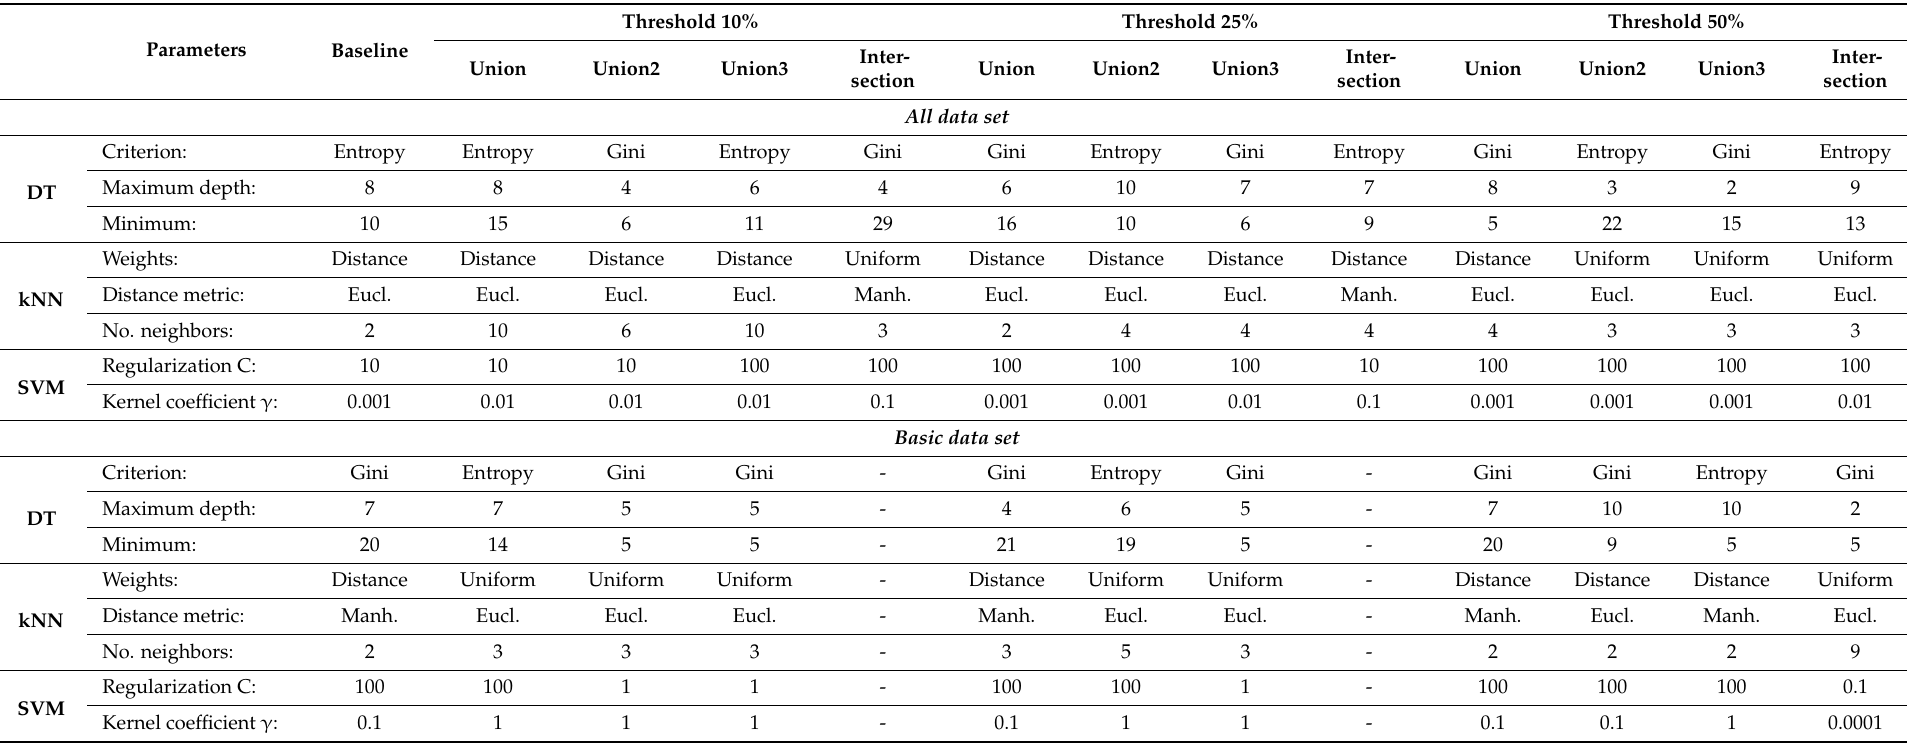
Table A1. Results of the hyperparameter optimization for each data set; Decision Tree (DT); k-Nearest Neighbor (kNN); Support Vector Machine (SVM); Euclidean (Eucl.); Manhattan (Manh.). Expanded Disability Status Scale (EDSS); Basic data set = 25 Foot Walk Test + 2-minute walk test + EDSS; All data set = All features of the Basic data set , the GAITRite System data sets, the Mobility Lab Gait data sets, the Twelve Item Multiple Sclerosis Walking Scale data set and the Early Mobility Impairment Questionnaire data set